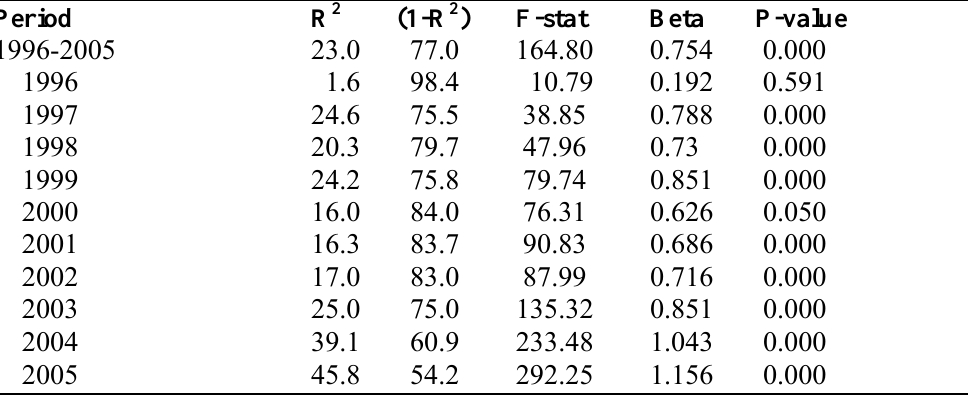
Model: NOSHLnVOLLn εβα ++= )()( iiii Vol = £ volume of shares traded; NOSH = number of shares outstanding; measures are mean annual results based on monthly regressions described by the